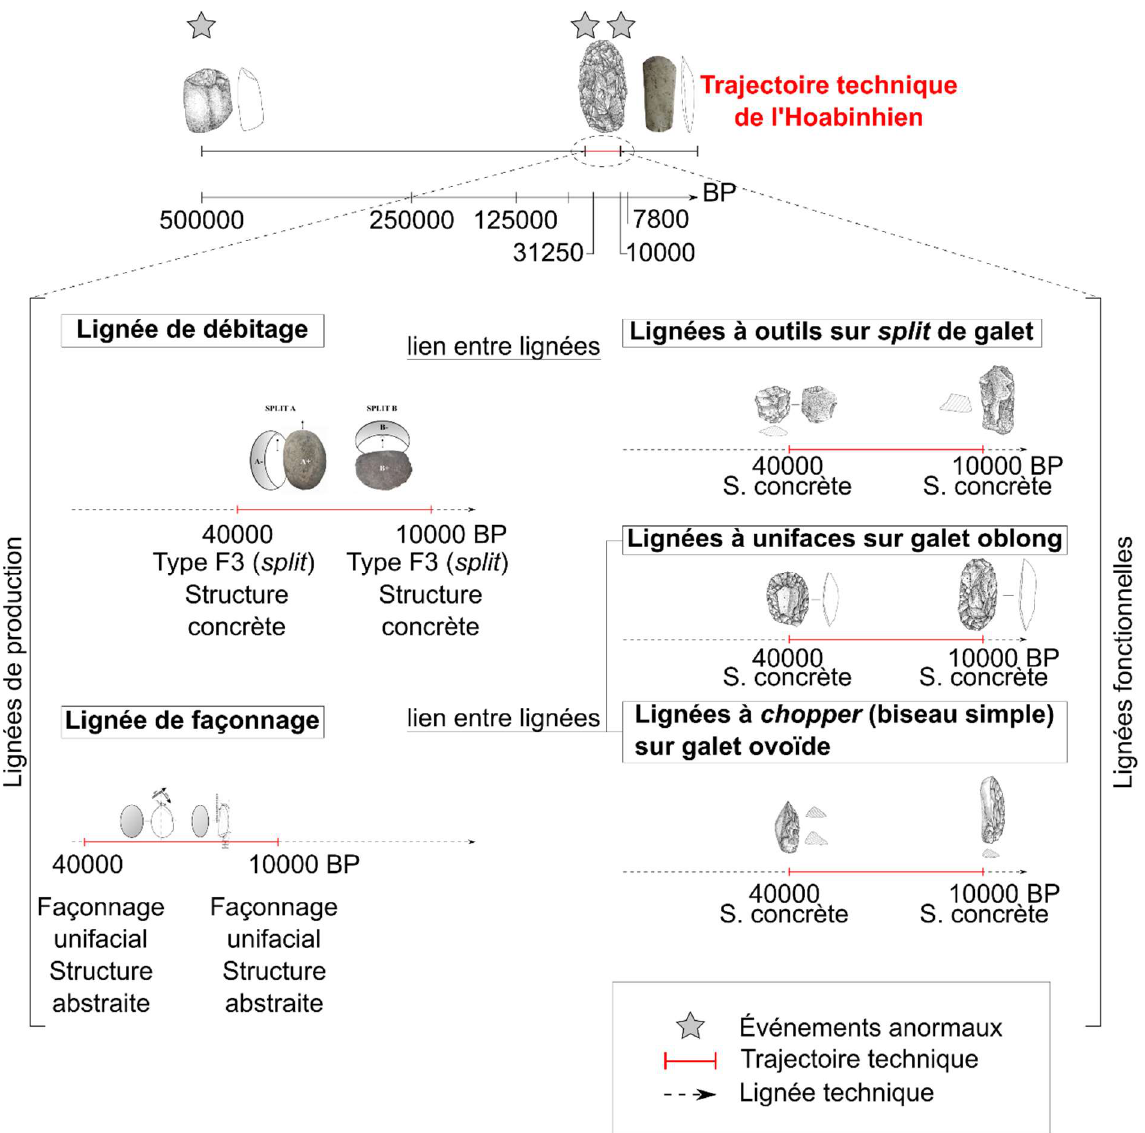
Figure 16. Exemple de trajectoire technique, le cas de l’Hoabinhien en Asie du Sud-Est (élaboré à partir